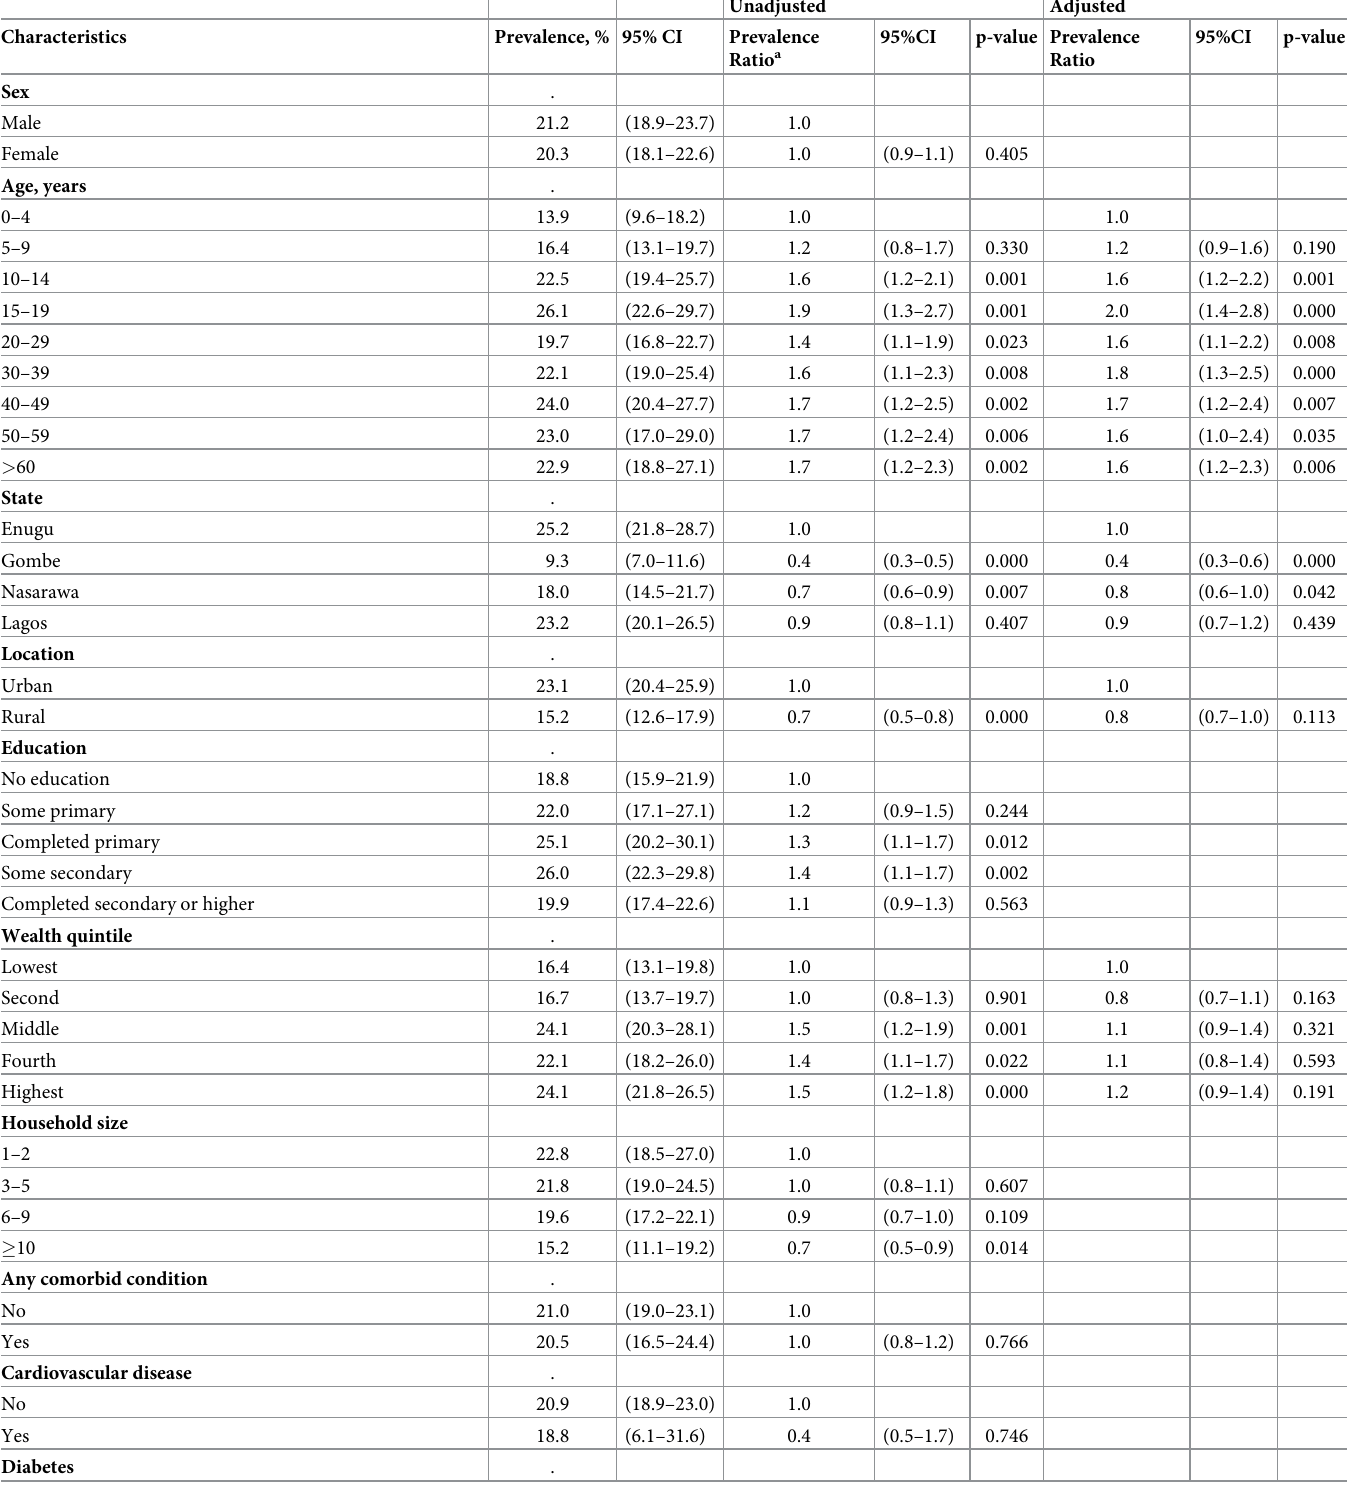
Table 4. Associations between presence of SARS-CoV-2 antibodies and demographic and behavioral risk factors in four states in Nigeria in October 2020 (n = 9,296).